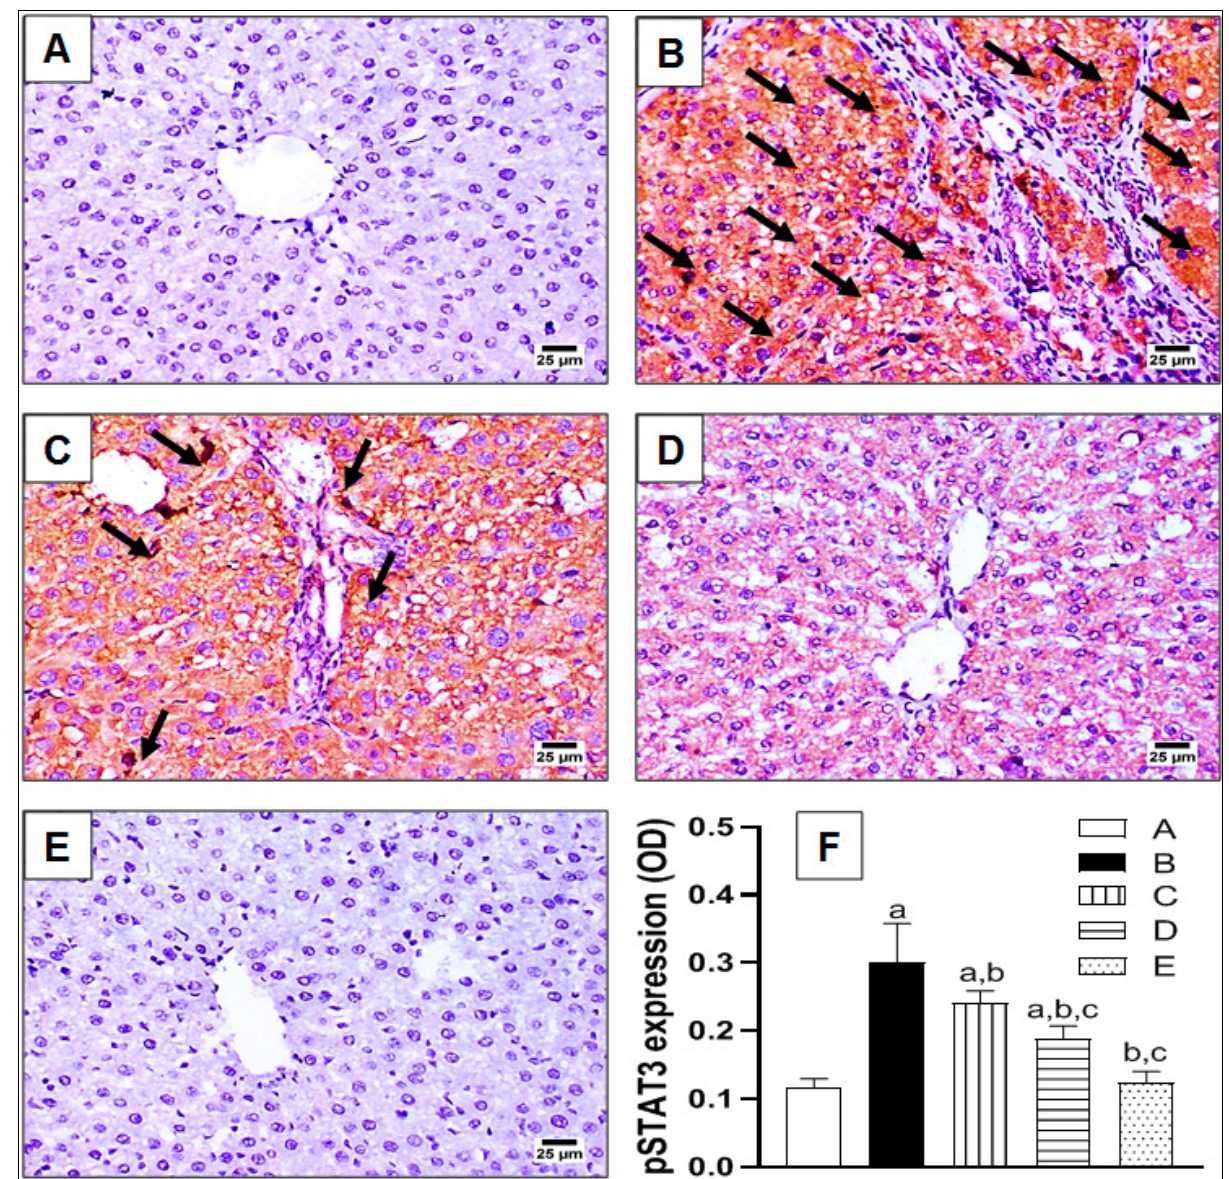
Figure 7. The effect of lycorine on the expression of phospho-STAT3 (pSTAT3) by immunohistochemical staining in a rat model of TAA-induced liver fibrosis. ( A ) Control group; ( B ): TAA-challenged group; ( C , D ) lycorine-treated groups at doses 0.5 and 1.0 mg/kg, respectively; ( E ) lycorine-alone group; ( F ) quantitative image analysis for pSTAT3 immunohistochemical staining, as optical density (OD) across 6 different fields. Data are presented as mean ± S.D. ( n = 6). (a), (b), (c) Statistically significant from the control, TAA, and TAA + lycorine 0.5 mg/kg/d groups, respectively, at p < 0.05 using one-way analysis of variance (ANOVA) followed by Tukey’s as a post- hoc test.